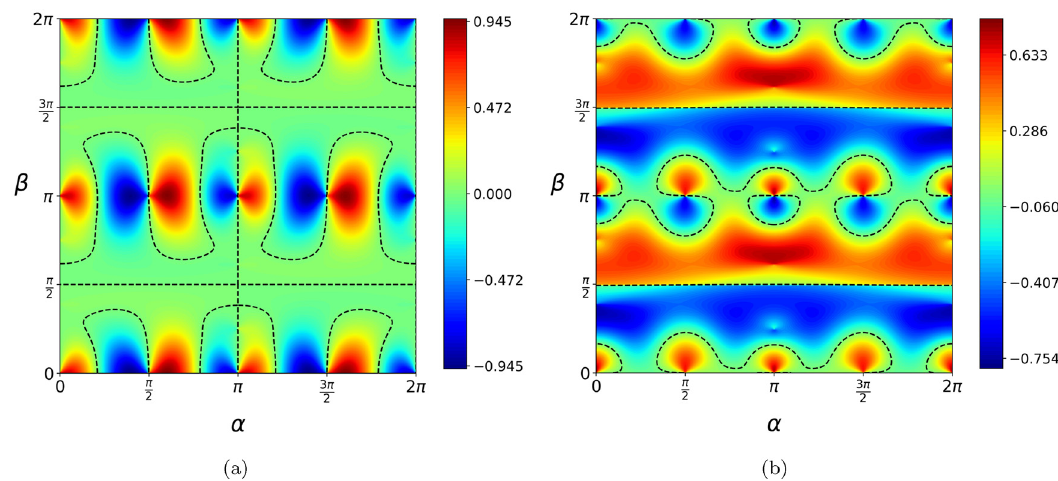
∂ . ( b ) Contour for ∂ α